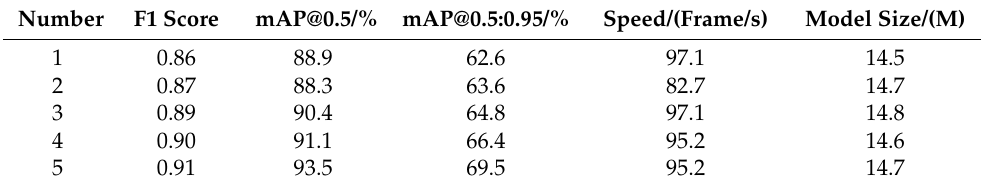
Table 3. Ablation comparison experiment results.